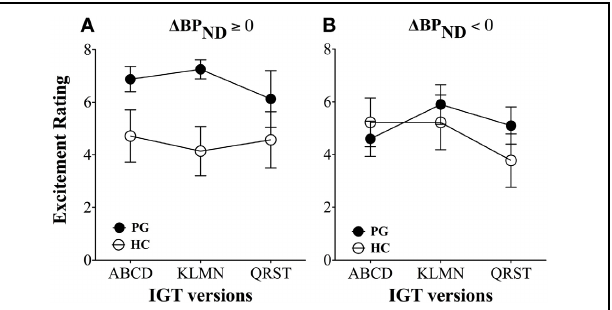
FIGURE 5 | Excitement levels between gambling disorder sufferers and healthy controls. (A) Gambling disorder sufferers (PG, filled circles) with dopamine release ( (cid:2) BP ND ≥ 0) have significantly higher excitement across games than healthy controls (HC, open circles) with dopamine release. (B) Gambling disorder sufferers (PG) and healthy controls (HC) without dopamine release ( (cid:2) BP ND < 0) do not differ in excitement level across games. Reprint with permission from Linnet et al. (2011b).